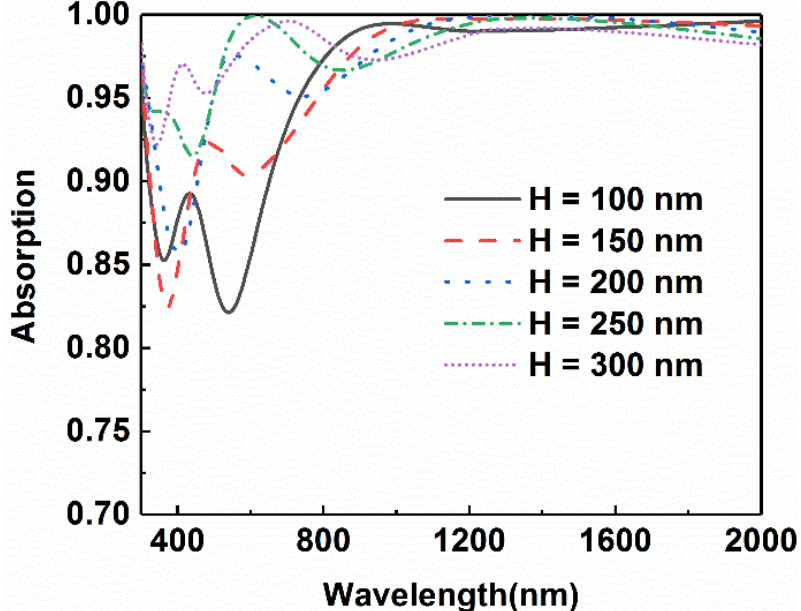
Figure 9. Comparison of light absorption of absorbers with different heights of the cross.